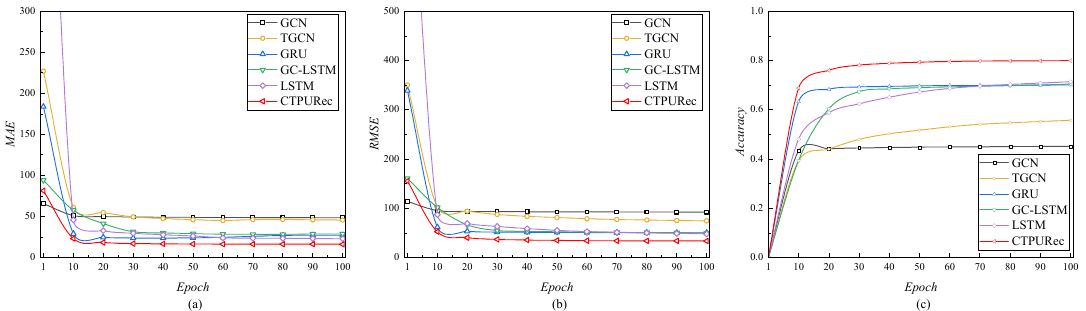
Figure 7. The metrics variations in the first 100 epochs based on validation data. The Figure 7a,b show the variation of MAE and RMSE, and Figure 7c is the the change of Accuracy.